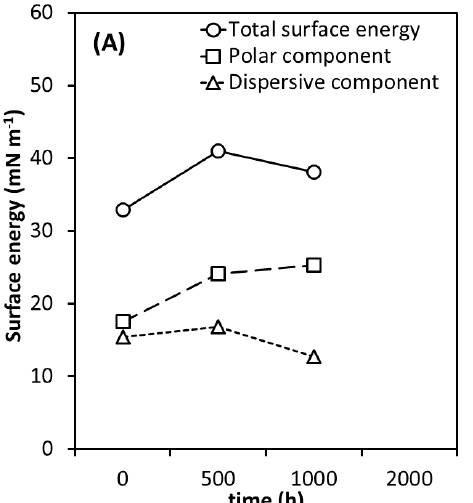
Figure 4. Contact angles (CAs) of water, formamide and ethylene glycol in ( A ) the PHBV and ( B ) the PHBV/TiO 2 as a function of increasing weathering exposure time.